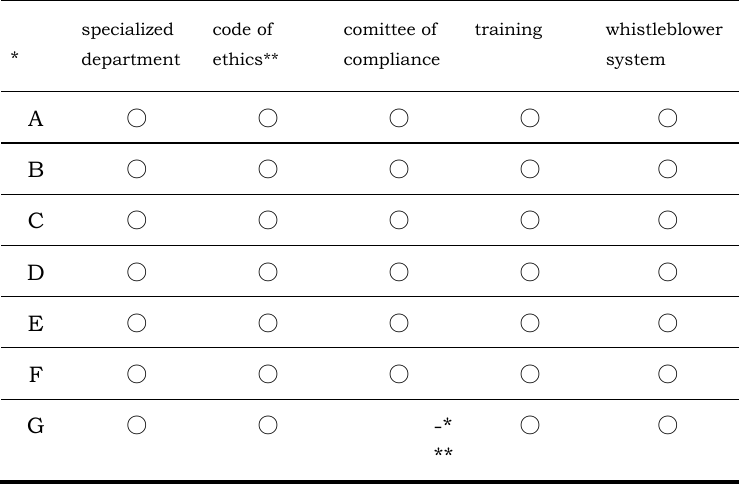
Table 1. Japanese firms’ compliance